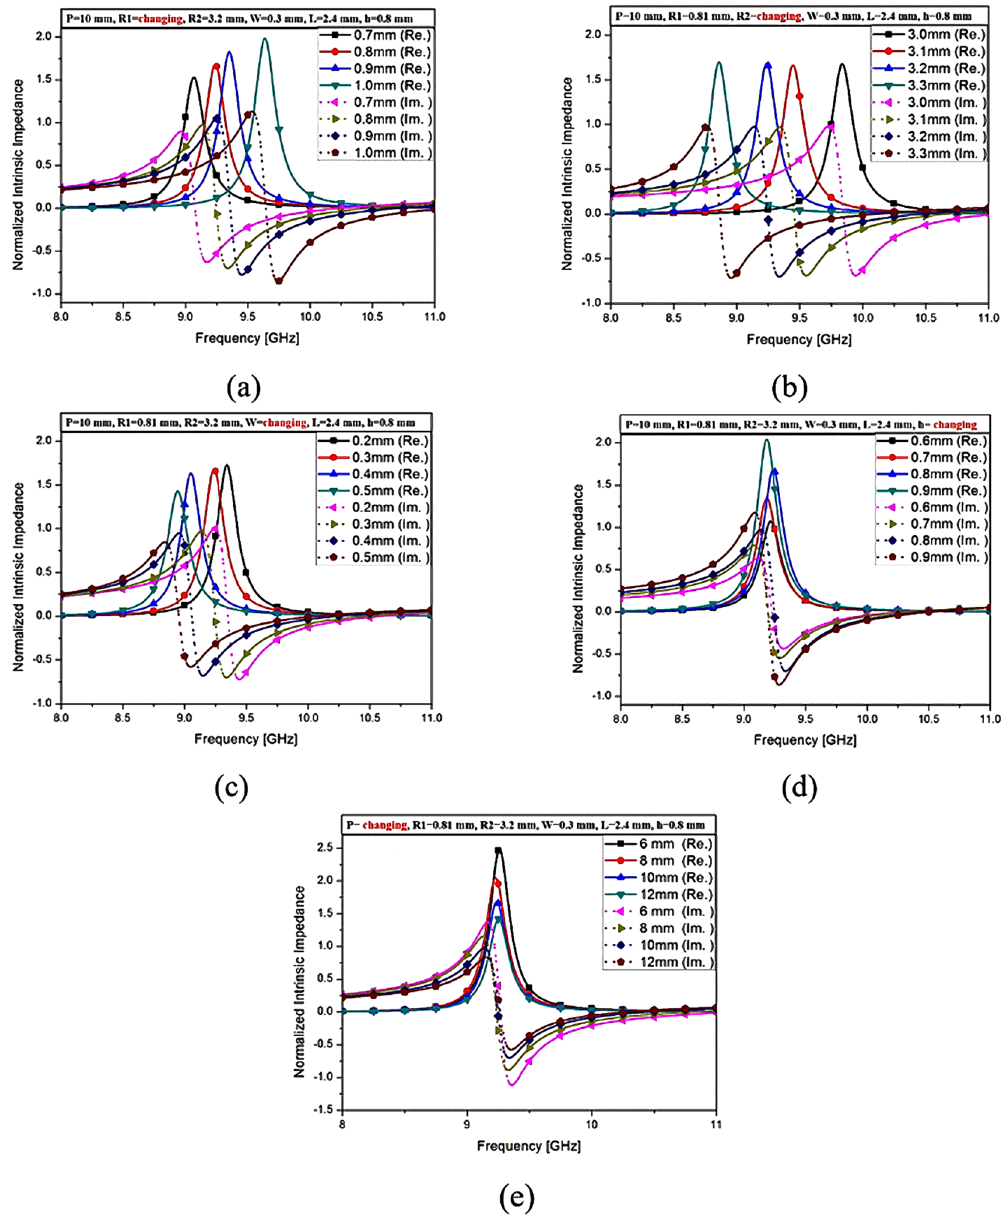
Figure 2. Simulated normalized complex impedances of the proposed MM absorber at different values of the parameters: ( a ) R 1 varying from 0.7 mm–1.0 mm, ( b ) R 2 varying from 3.0 mm–3.3 mm, ( c ) W varying